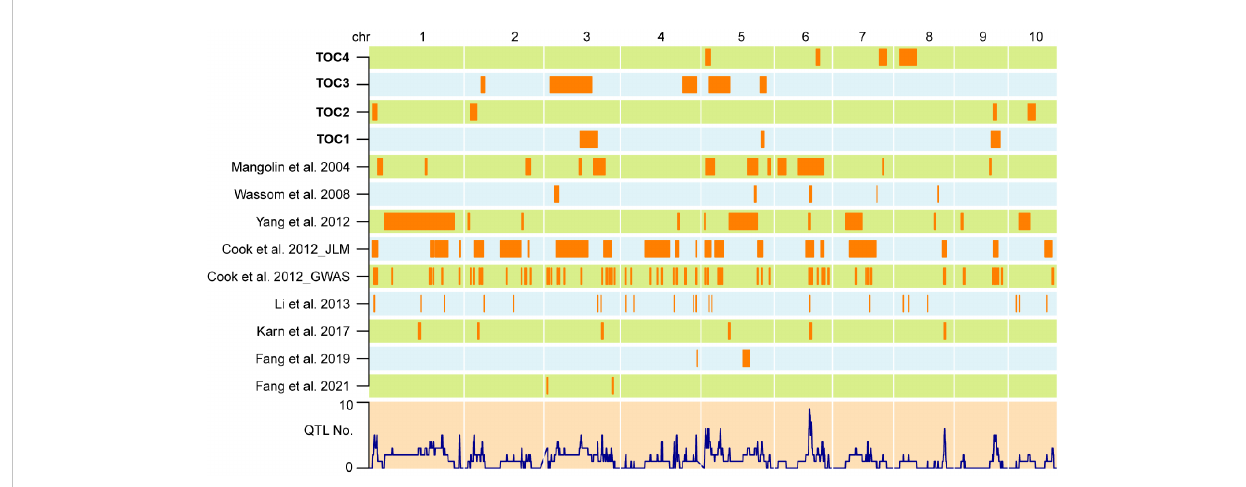
FIGURE 3 Co-localization of TOC QTLs in maize kernels identi fi ed in the present and previous studies. The QTLs identi fi ed in this study were represented on top. QTLs detected in previous studies were displayed in the form of references. The lower layer showed the number of detected